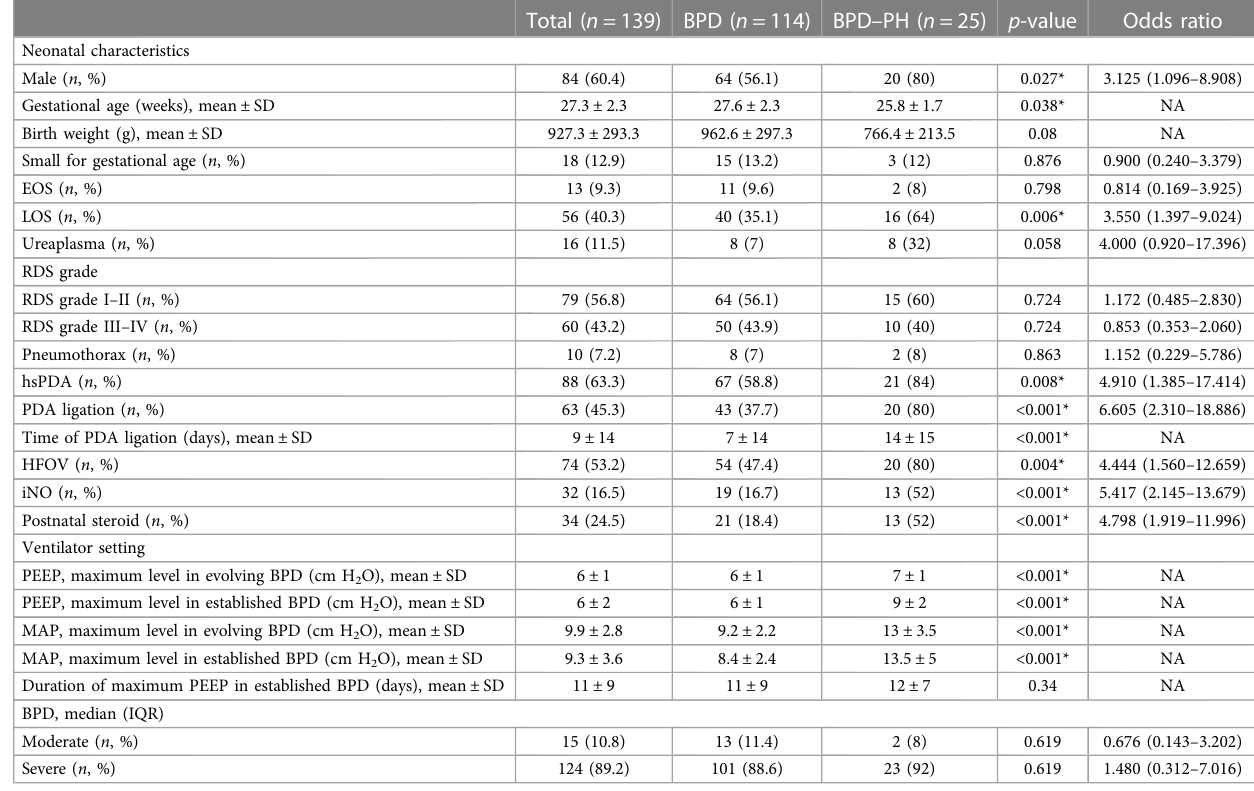
TABLE 2 Characteristics of preterm infants with bronchopulmonary dysplasia with and without pulmonary